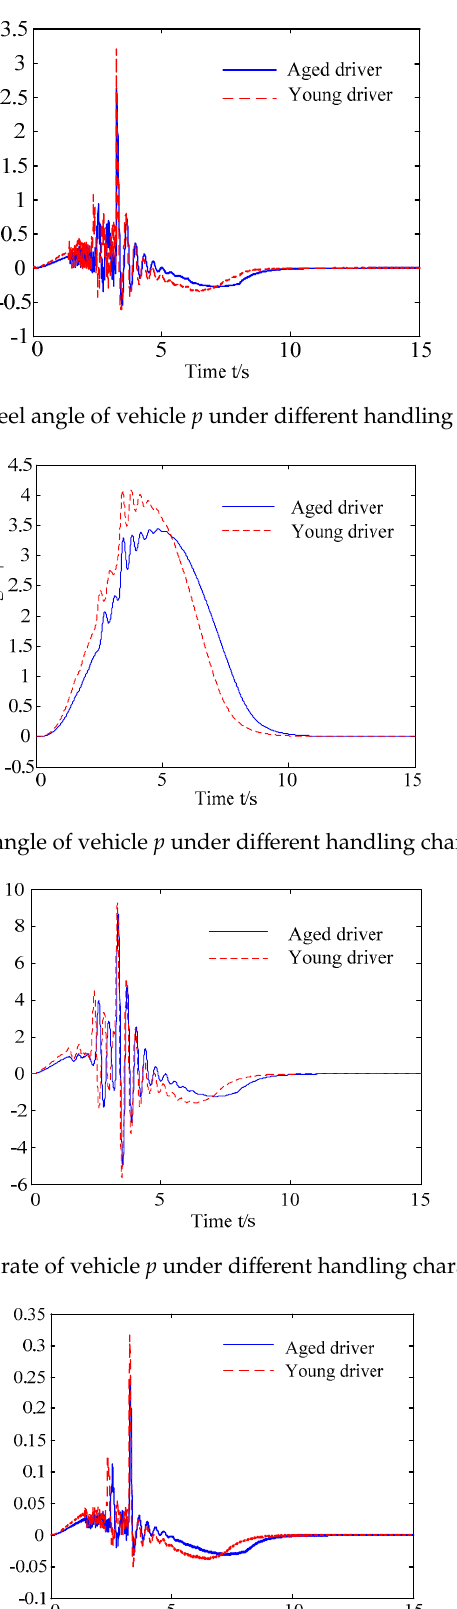
Figure 25. Lateral acceleration of vehicle p under different handling characteristics.